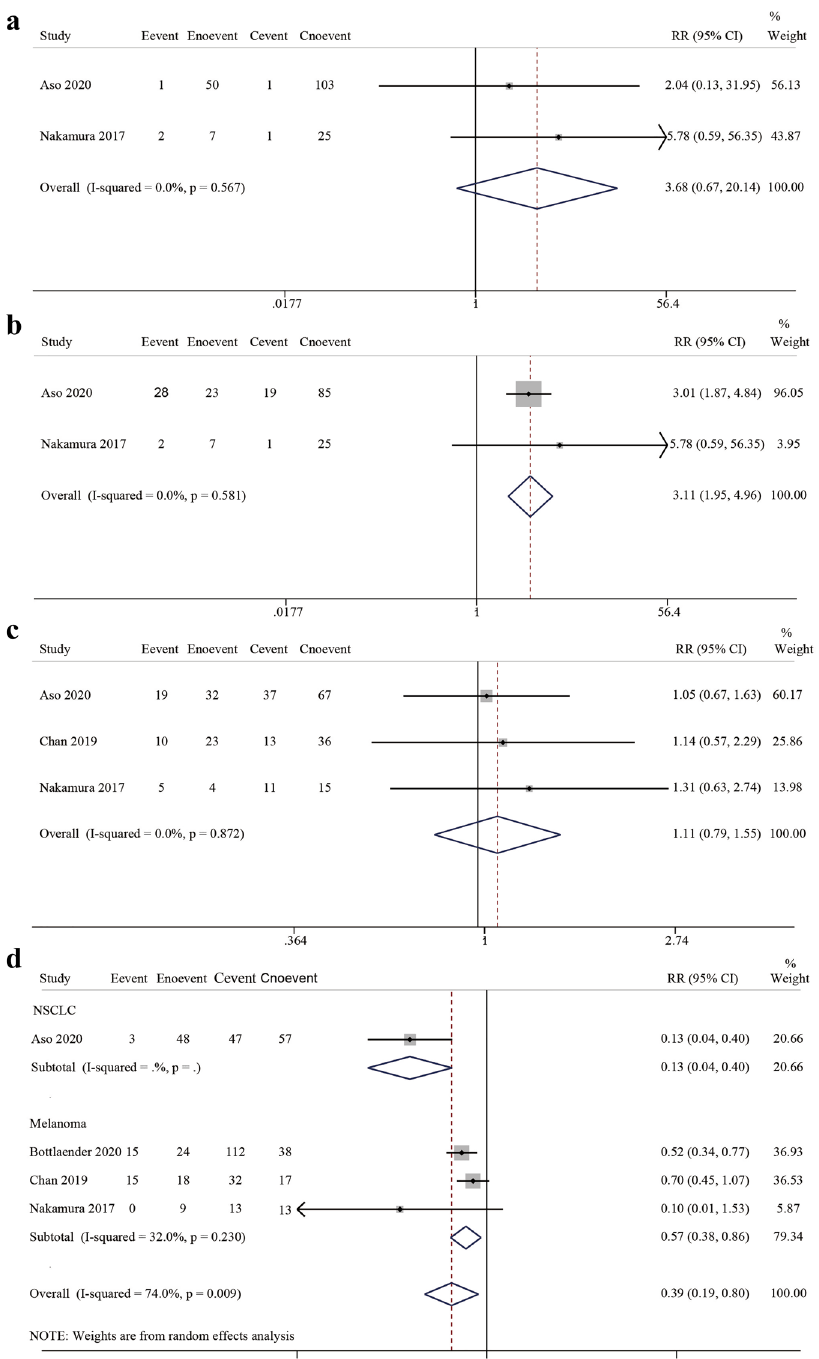
Figure 3. Forest plot showing the association between irCAE occurrence and CR, PR, SD, and PD. ( a ) CR, ( b ) PR, ( c ) SD, and ( d ) subgroup analysis among cancer types and PD. IrCAEs, immune-related cutaneous adverse events; CR, complete remission; PR, partial remission; SD, stable disease; PD, progressive